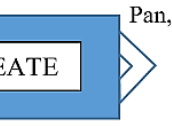
Figure 11. BigchainDB CREATE Transaction.